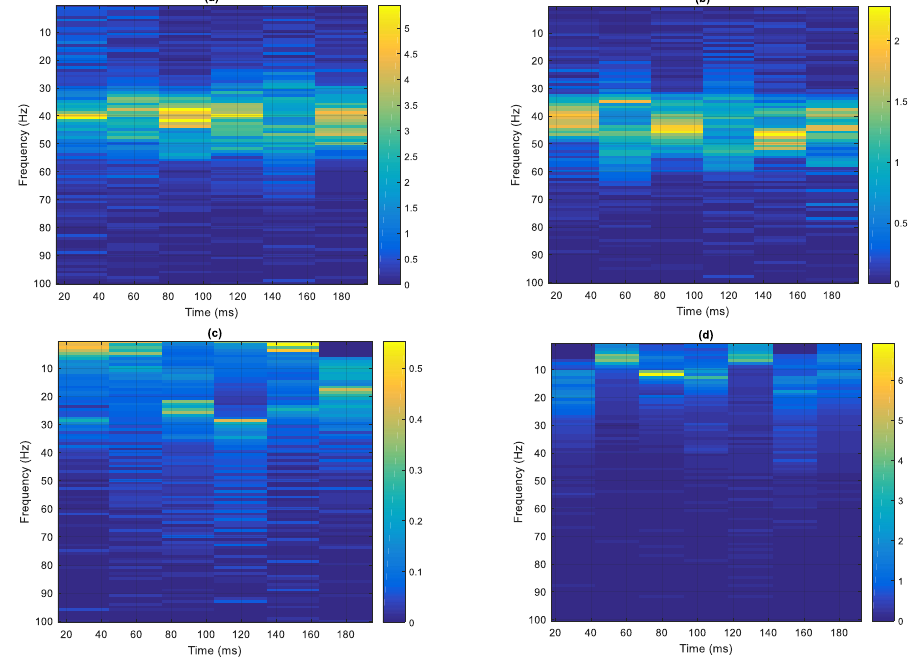
Figure 7. An average frequency – energy distribution of class II ( a ) MF1, ( b ) MF2, ( c ) MF3, and ( d ) MF4.